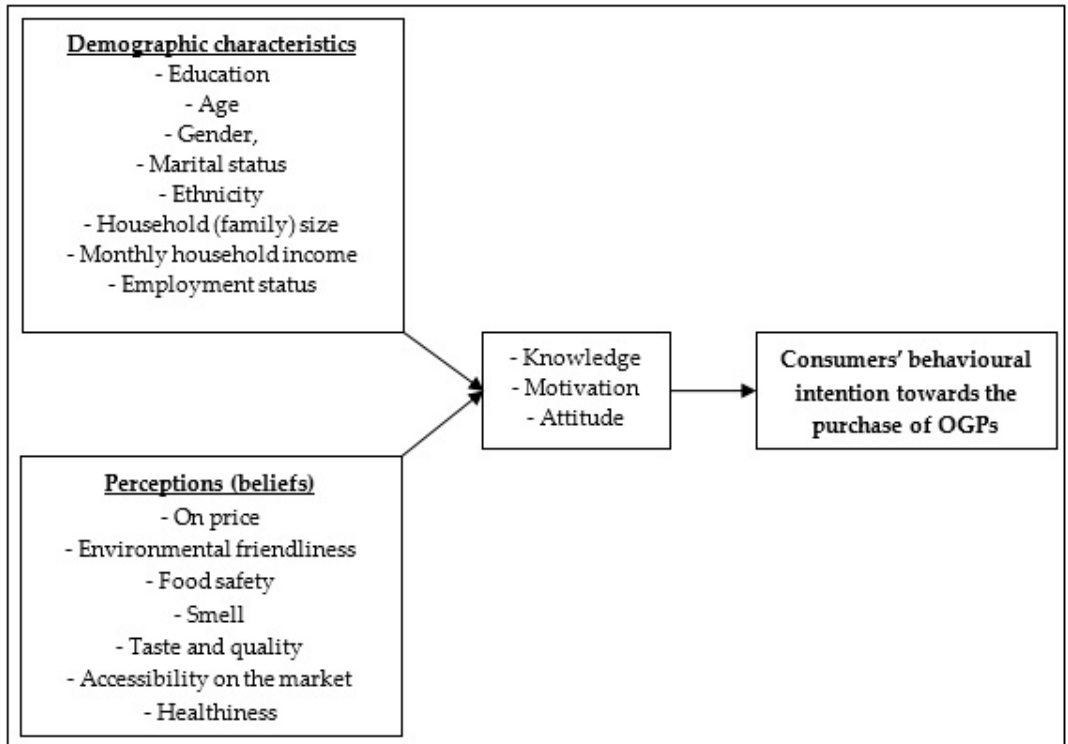
Figure 2. The conceptual framework of the factors influencing consumer purchase intentions of OGPs.